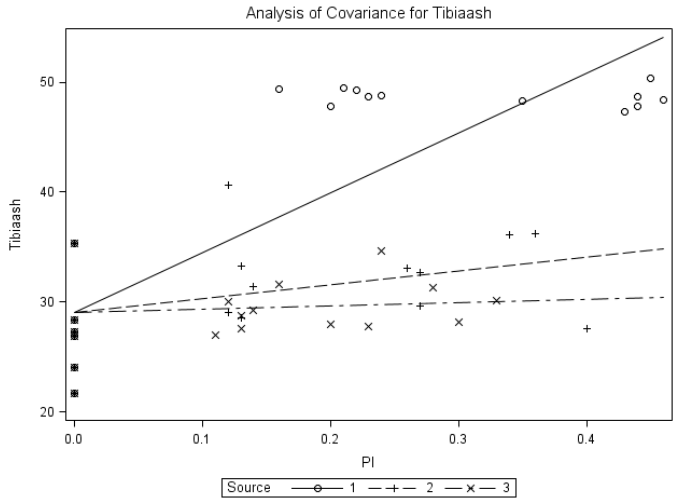
Figure 3. Common-intercept, multiple-linear regression of relative amount of tibia ash (tibiaash; %) on supplemental P intake of chicks fed diets supplemented with P from monosodium phosphate (MSP; Source 1), brown-seeded pea (BP; Source 2), and Yellow-seeded pea (YP; Source 3). The circular marker represents MSP, the plus marker represents BP, and the multiplication marker represents YB. The common-intercept, multiple-linear regression equation (mean±standard error) was Y = 29.06±1.03+54.40±5.04MSP+12.49±6.92BP +3.05±8.09YP, R2 = 0.72, p<0.0001; the relative bioavailabilities estimated by slope-ratio were 23.0% and 5.60% for BP and YP, respectively.